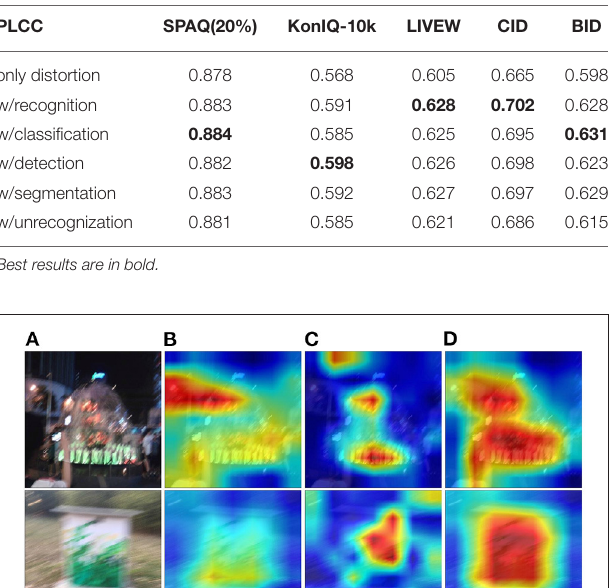
TABLE 4 | Results of training the distortion network from scratch on 80% KonIQ-10k.